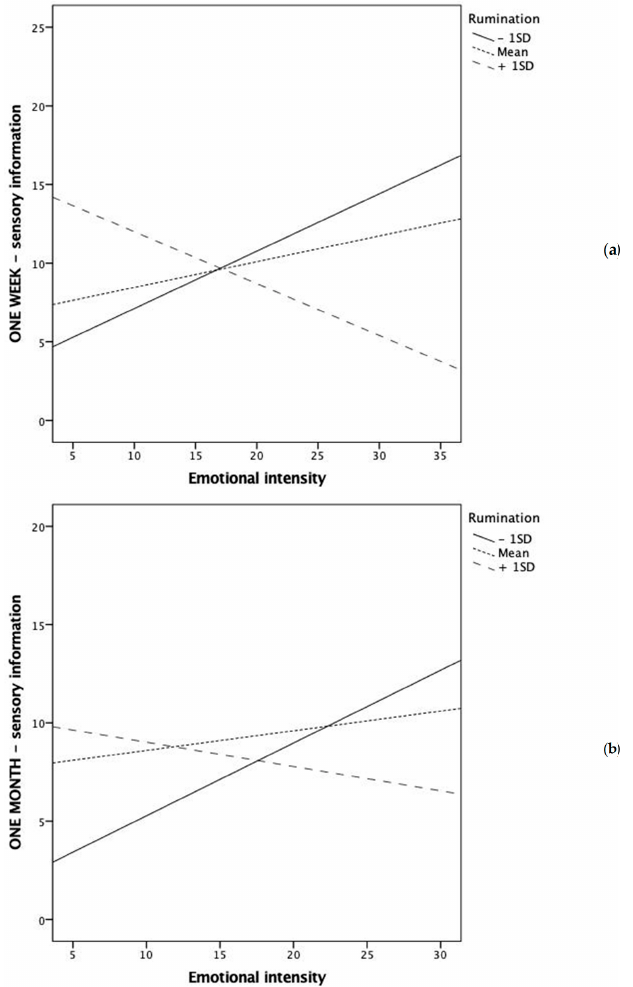
Figure 1. Graphical representation of the significant interaction between rumination and emotional intensity in predicting emotional involvement at one-week ( a ) and one-month ( b ) follow-up assessments.